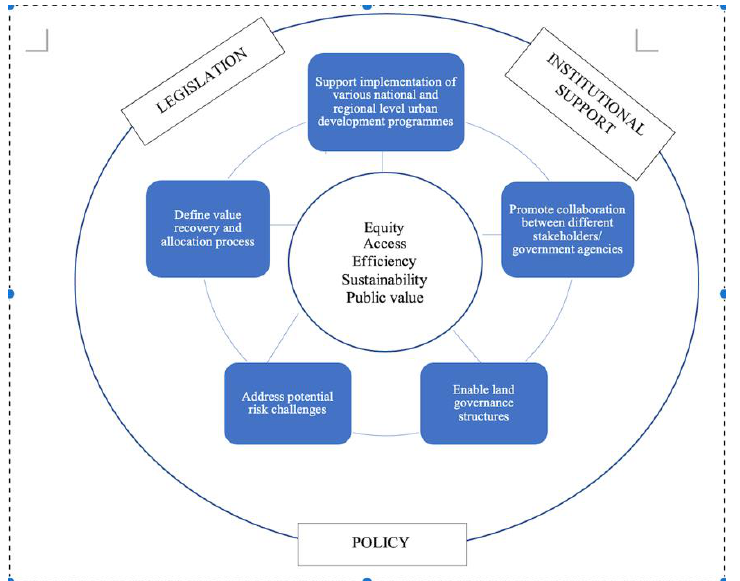
Figure 2. Framework for analyzing land-based financing elements in policies.